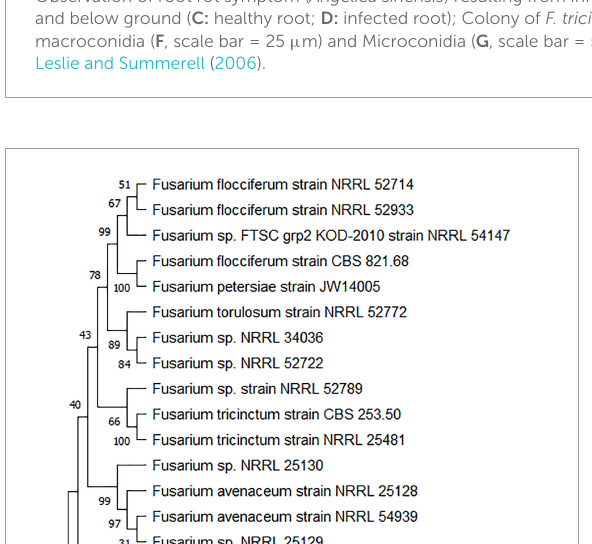
FIGURE2 Maximum-likelihood (ML) phylograms obtained from the combined partial TEF and RPB2 data set (2,487 bp) of the Fusarium tricinctum species complex (FTSC) isolates. Sequences were used to conduct BLASTn queries of NCBI GenBank (https://www.ncbi.nlm.nih.gov/). Aligned sequences of 17 FTSC reference strains were combined and analyzed via ML bootstrapping using MEGA 11. Bootstrap values (%) are shown on